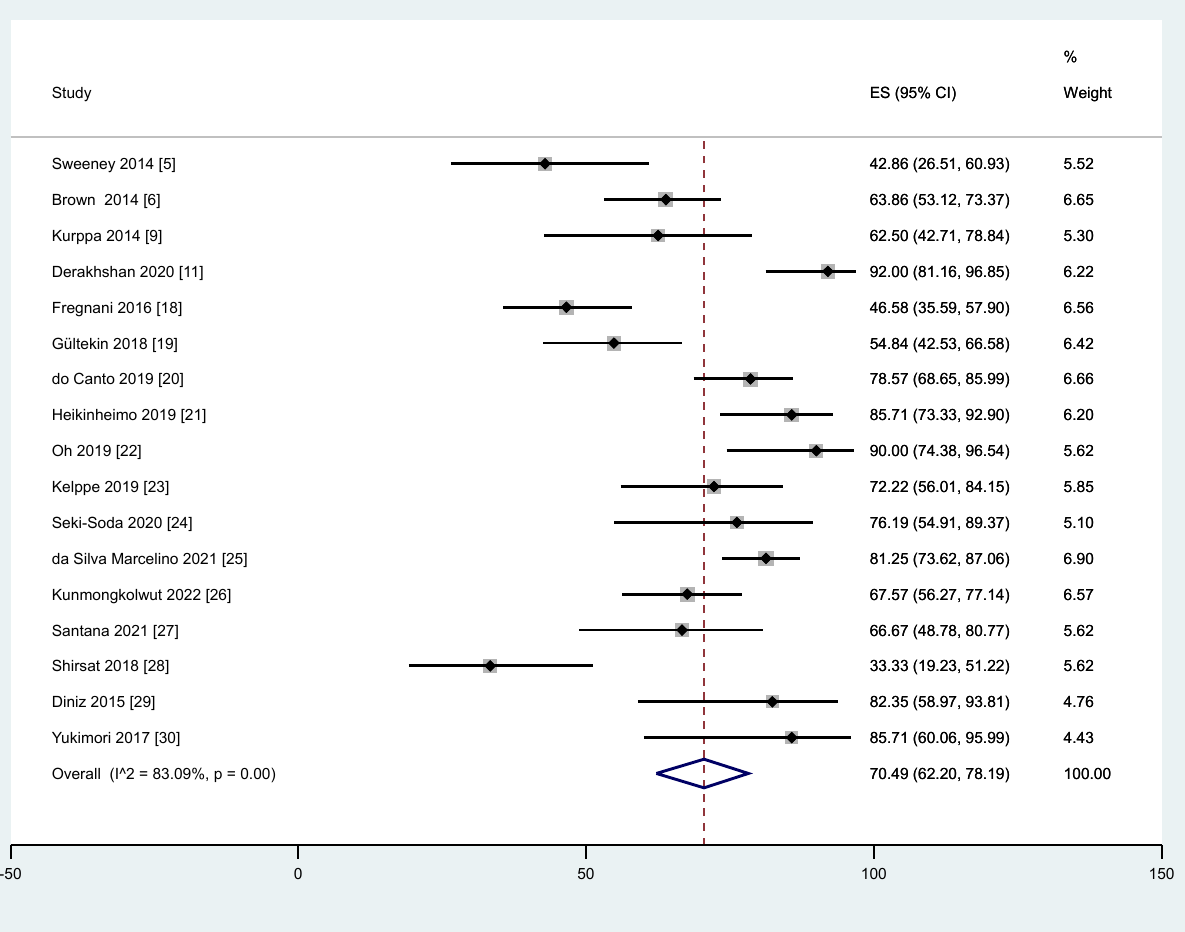
Overall (I^2 = 83.09%, p =